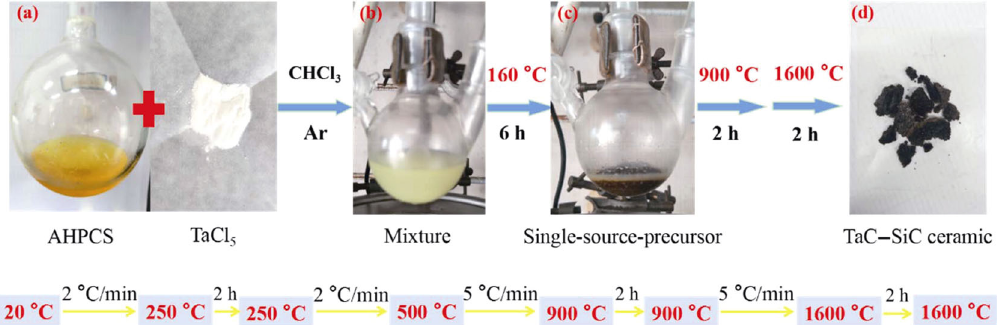
Fig. 1 Photographic description of the synthesis process and heating